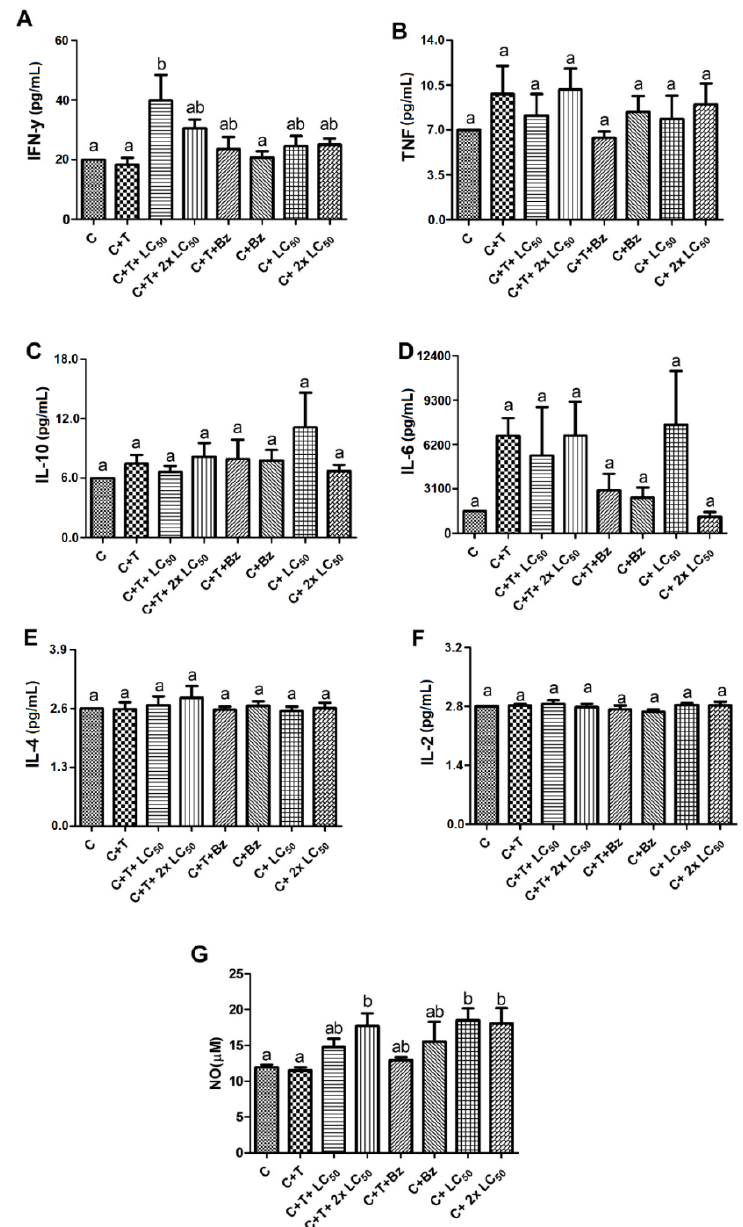
Figure 5. Effect of M. oleifera flower trypsin inhibitor (MoFTI) on the production of cytokines ( A – F ) and nitric oxide ( G ) by human peripheral blood mononuclear cells (PBMCs) infected or not with T. cruzi trypomastigotes after 120-h exposure. The treatments were: negative control (C = untreated and uninfected PBMCs); untreated PBMCs infected with trypomastigotes (C + T); infected PBMCs treated with MoFTI at 43.5 µg/mL (C + T + LC 50 ) and 87.0 µg/mL (C + T + 2 × LC 50 ); infected PBMCs treated with benznidazole (C + T + Bz); uninfected PBMCs treated with benznidazole (C + Bz); uninfected PBMCs treated with MoFTI at 43.5 µg/mL (C + LC 50 ) and 87.0 µg/mL (C+ 2 × LC 50 ). Different letters (a,b) indicate significant differences between treatments by analysis of variance (ANOVA) followed by the Tukey post-test ( p < 0.05).